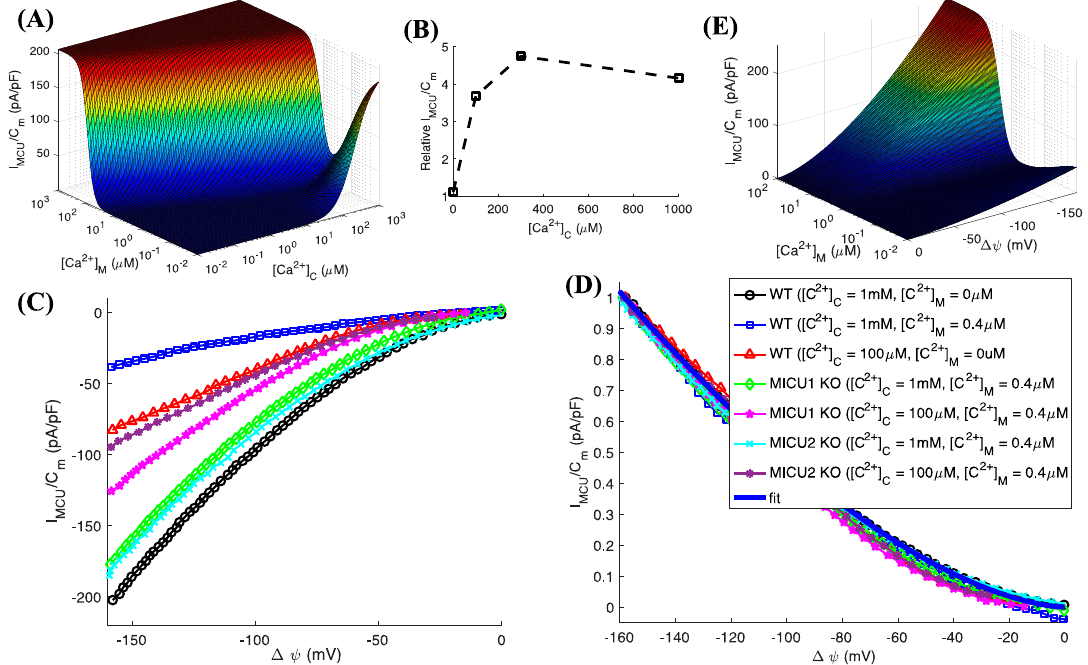
Figure 2. MCU current density as a function of [Ca 2+ ] C , [Ca 2+ ] M , and Δψ . ( A ) The inverted bell-shaped behavior of the MCU Ca 2+ flux changes into a biphasic behavior with almost zero and optimal current density at low and high [Ca 2+ ] M respectively as we decrease [Ca 2+ ] C ; ( B ) the ratio of I MCU /C m observed at [Ca 2+ ] M = 0 μ M to that observed at [Ca 2+ ] M = 0.4 μ M in WT mitoplasts at different [Ca 2+ ] C values. ( C ) raw and ( D ) normalized I MCU /C m (normalized with respect to the minima (maximum Ca 2+ influx) of the trace) at different [Ca 2+ ] C and [Ca 2+ ] M values as we vary Δψ in WT, MICU1 KO, and MICU2 KO mitoplasts. Thick solid line in (D) represents model fit; ( E ) I MCU /C m given by the model as a function of [Ca 2+ ] M and Δψ at [Ca 2+ ] C = 100 μ M. Experimental data shown for comparison is from [19] (B–D).